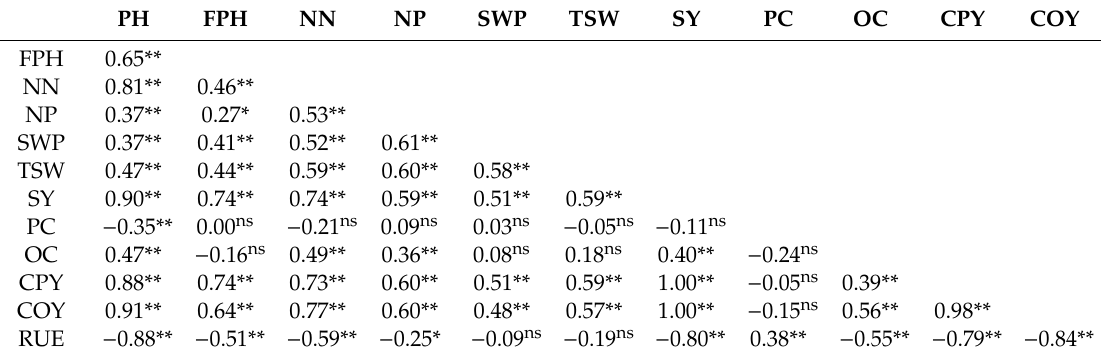
Table 3. Correlation matrix (Pearson) between studied parameters (n =